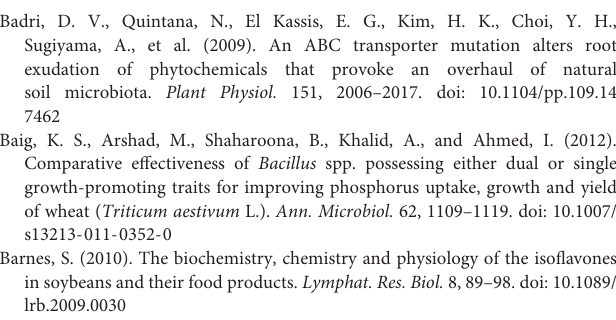
Supplementary Figure 1 | Fluorescence emitted by WS32-L